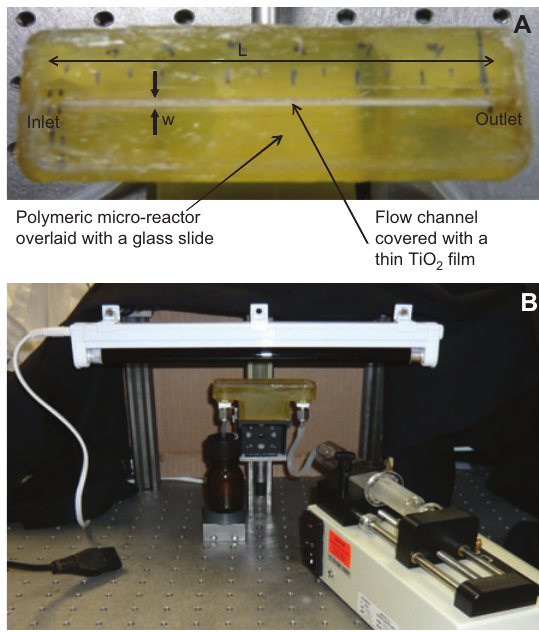
Figure 1 (A) Photographic view of the polymeric microchannel reactor fabricated in epoxy resin by stereolithography. (B) Expe- rimental setup for photocatalytic reactions with a microchannel